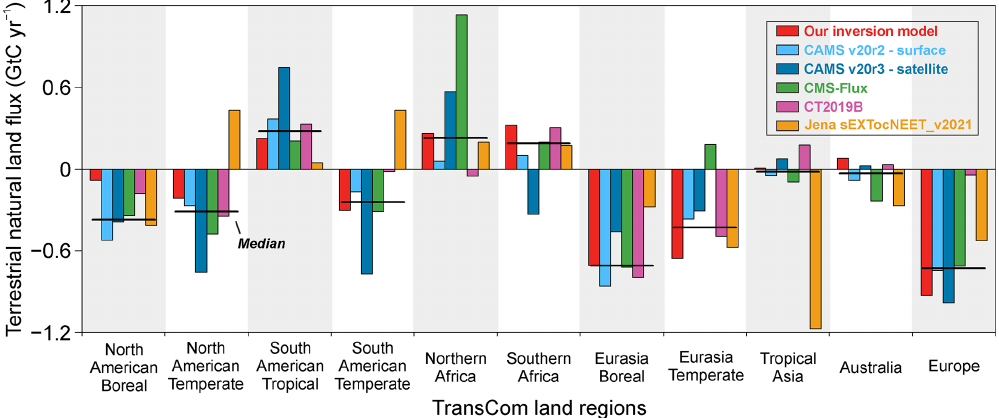
Figure 5. Terrestrial natural land fluxes derived over the 11 TransCom land regions from 2015 to 2018. Each atmospheric inversion is represented by bars showing the posterior natural land flux (i.e., terrestrial biospheric + fire fluxes) averaged between 2015 and 2018 in each TransCom land region; the black lines represent the median values of all six inversion estimates. The colors of the atmospheric inversion models are the same as those shown in Fig. 3, and the references for each inversion model are included in the caption of Fig. 3.